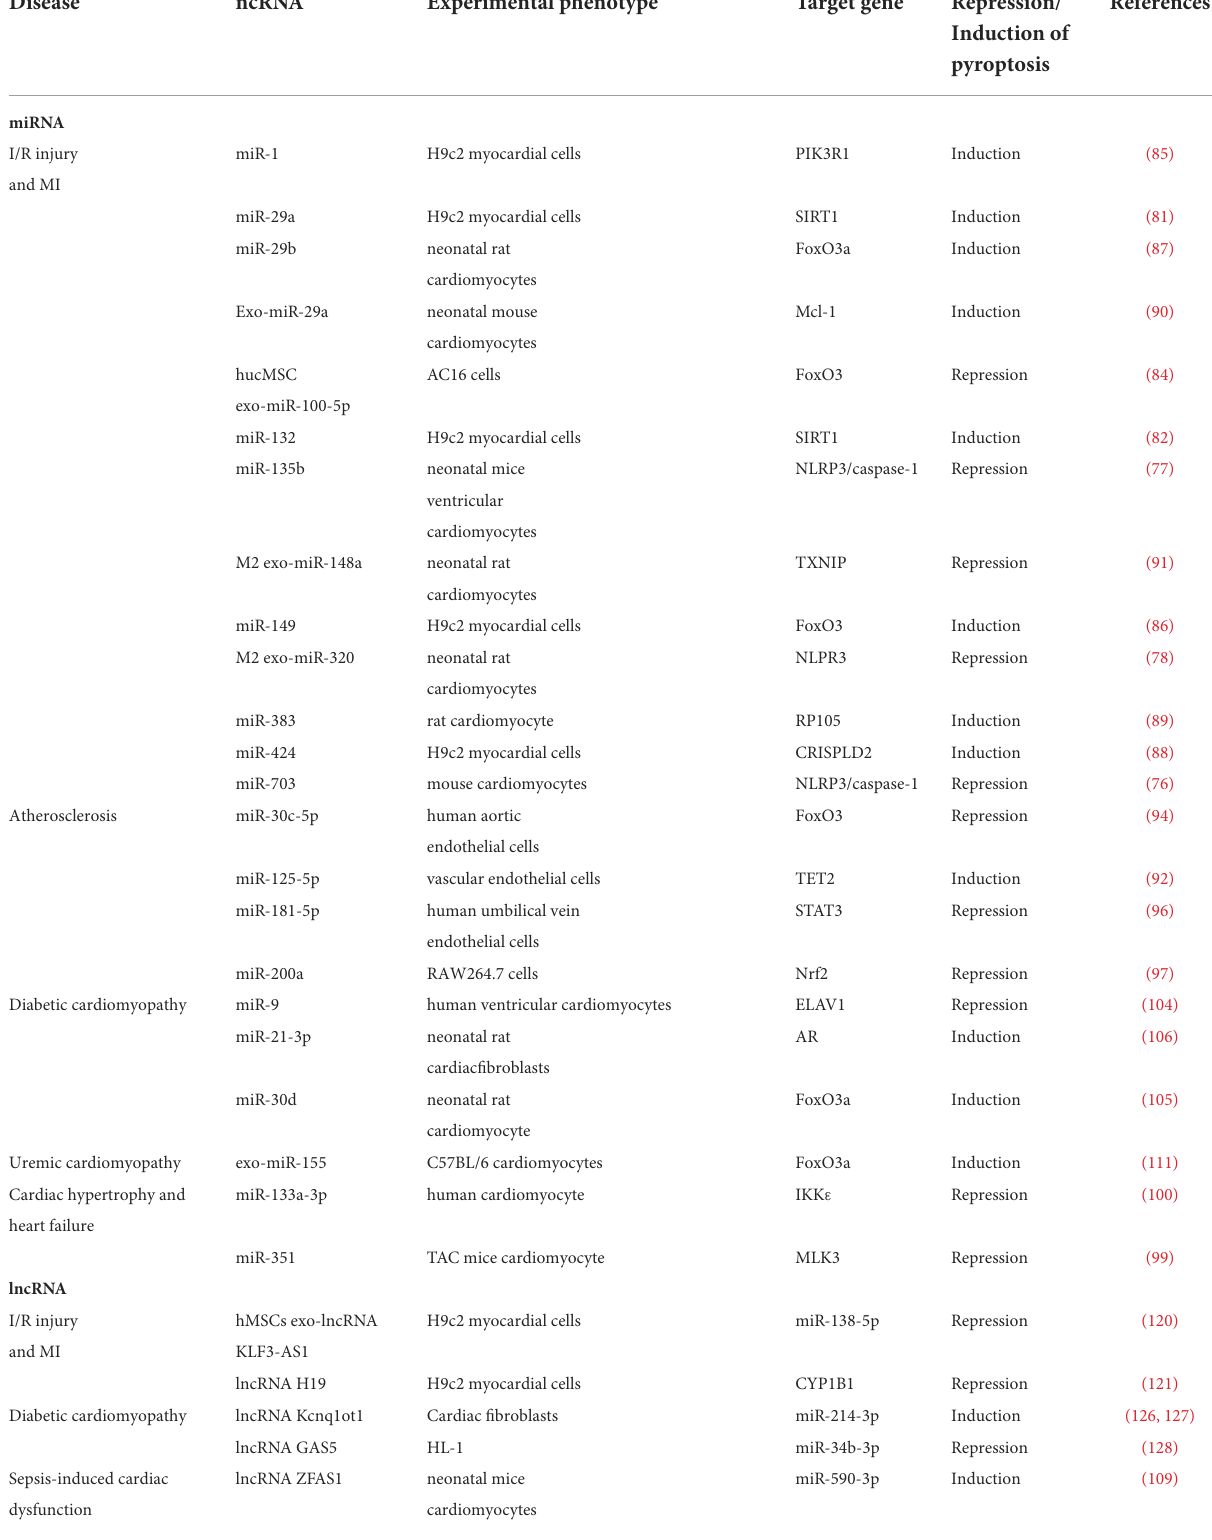
TABLE 2 Non-coding RNAs regulate pyroptosis in various types of CVDs.